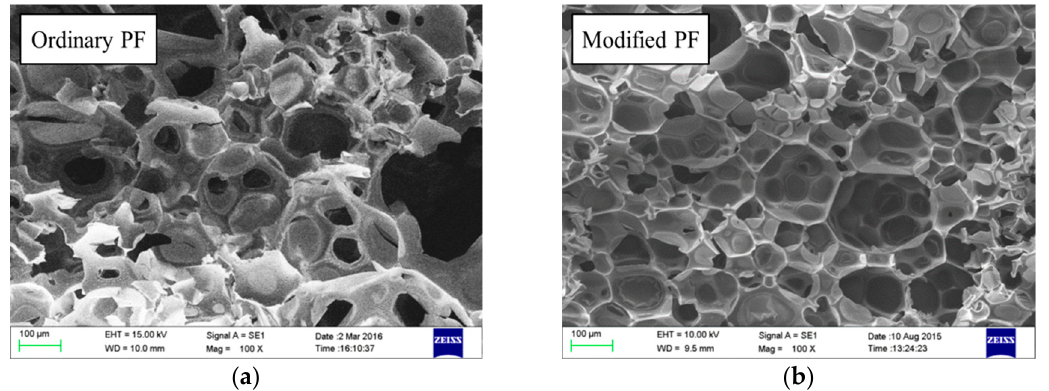
Figure 11. The SEM of PF ( a ) Ordinary PF; and ( b ) Modified PF with the amount of 3-pentadecyl-phenol being 15% of the total amount of phenol.